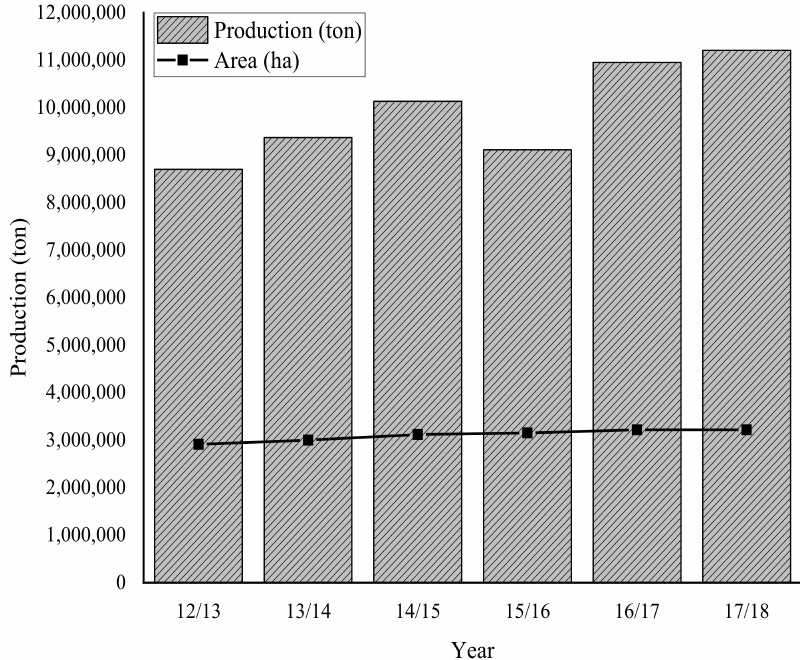
Figure 4. Production per growing season and the annual area used for soybean sowing in the north–central region of the State Mato Grosso, Brazil. Source: [46].